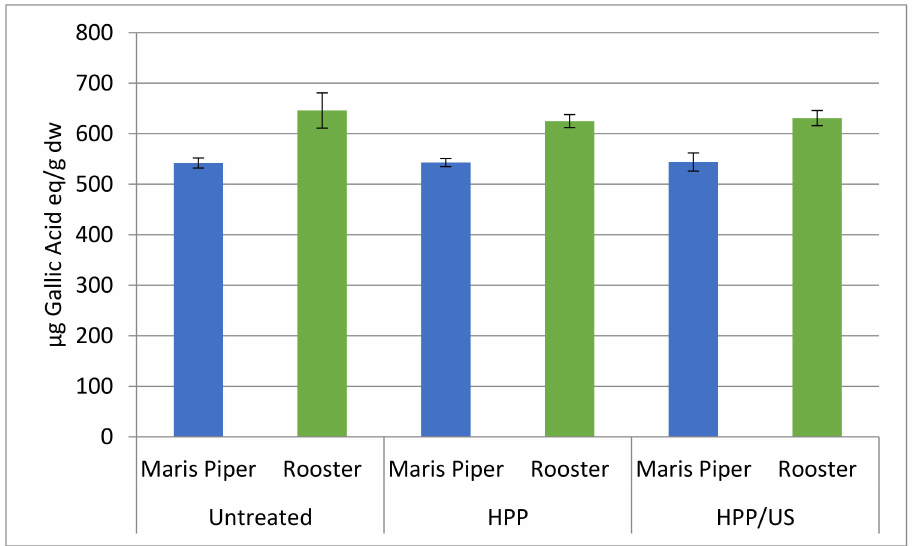
Figure 2. The effect of HPP and HPP/US treatment on total phenolic content expressed as µ g gallic acid equilavent per gram dry weight of minimally processed potatoes of the Maris Piper and Rooster